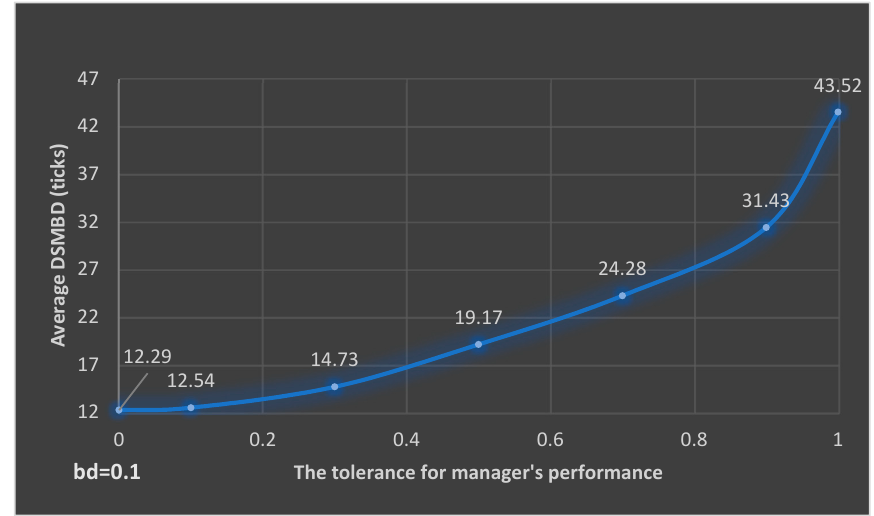
Figure 5. Average DSMBD versus the tolerance for manager’s performance, when bd = 0.1 and S1 is considered.